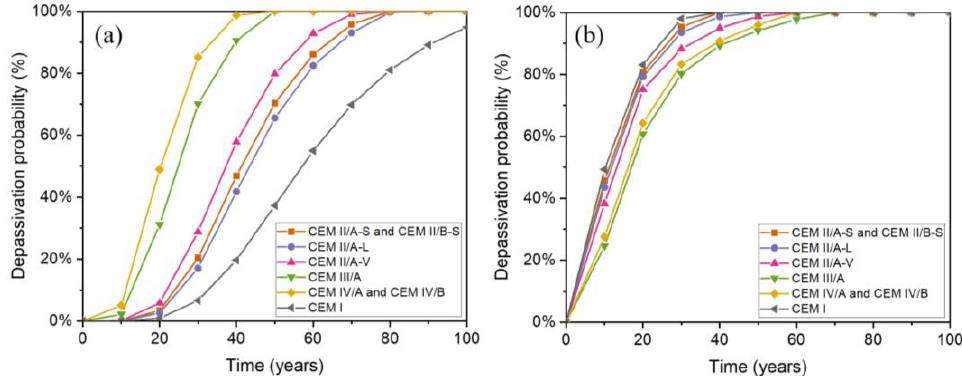
Figure 10. Depassivation probability in function cement type and for ( a ) CO 2 or ( b ) Cl − diffusion.